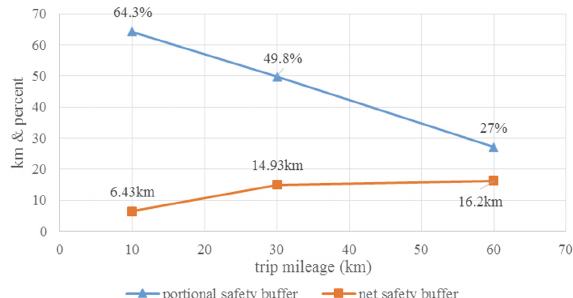
Figure 2: Net safety buffer and fractional safety